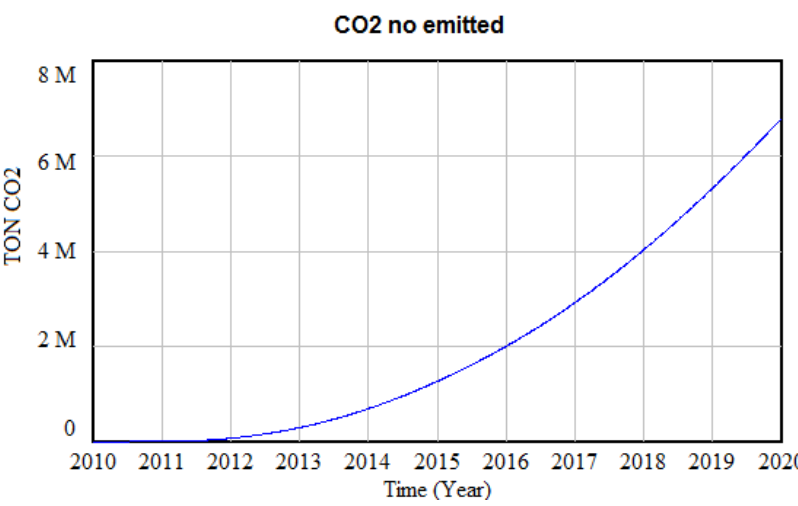
not emitted (the authors’ 2